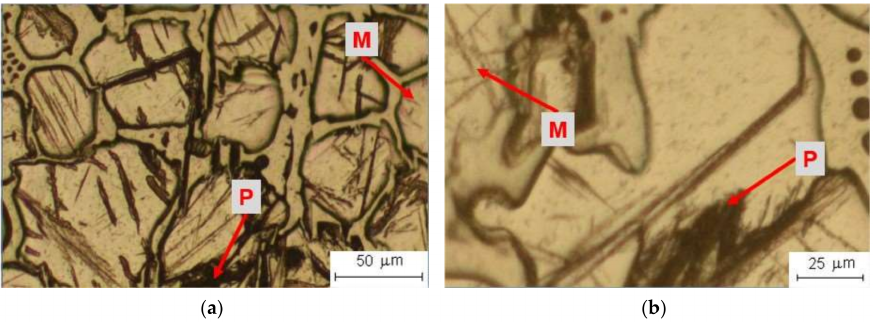
Figure 3. Marshall reagent for 60 s at room temperature: ( a ) general view at 200 × ; ( b ) detail at 500 × . 3.4. Attack 4—Attack 3 (Marshall Reagent for 60 s at Room Temperature) + 5% Ammonium Persulfate at Room Temperature